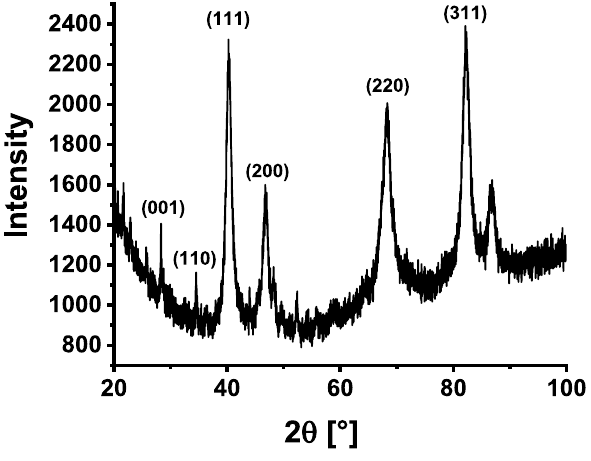
Fig. 2 XRD pattern of the FePt